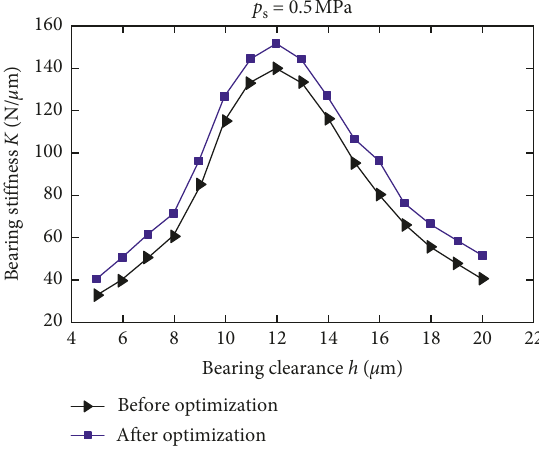
Figure 11: Comparison of bearing stiffness.